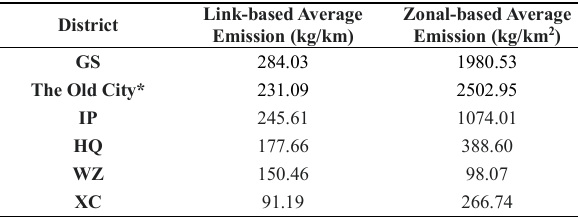
Table 7. Link-based and zonal-based average emission by district